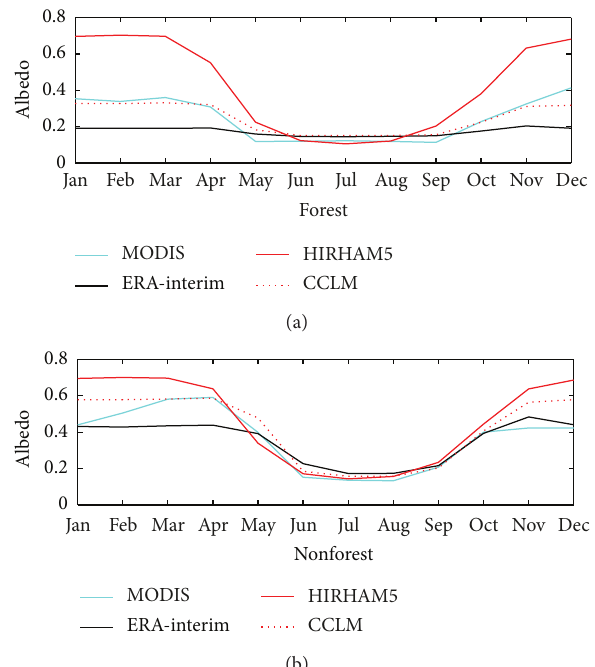
Figure 10: Annual cycle of surface albedo for Siberian subdomain derived from HIRHAM5, CCLM, ERA-interim and MODIS averaged over 2008 to 2010 for forest (a) and nonforest (b) areas.